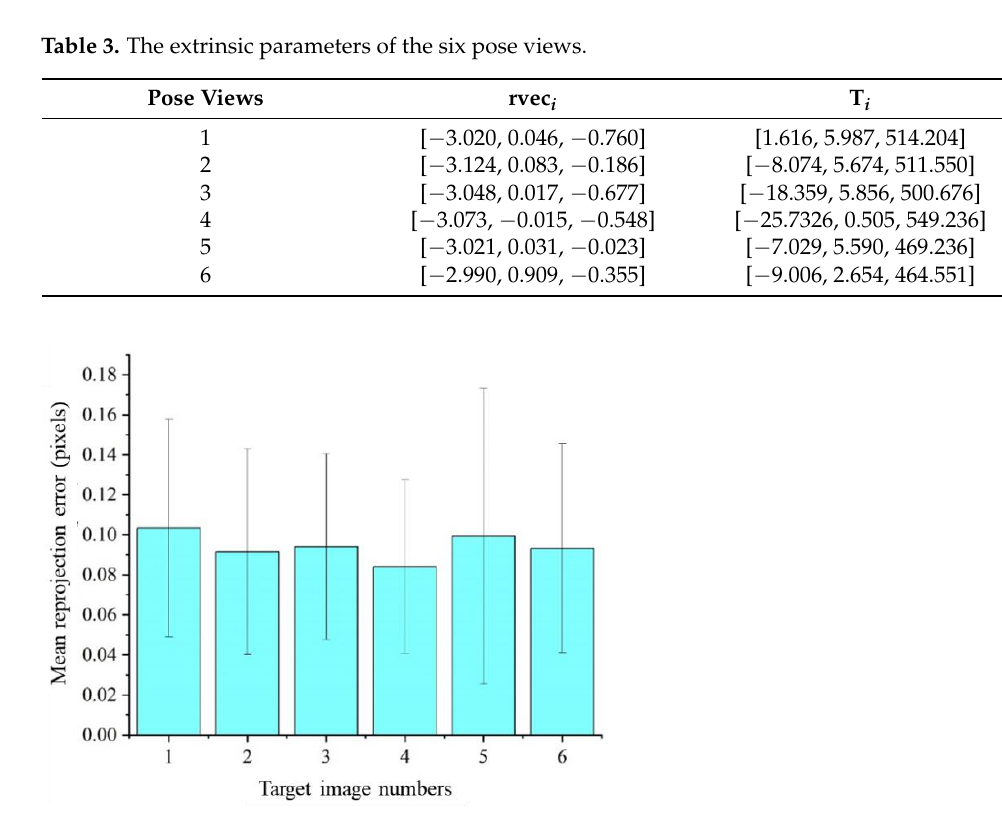
Figure 13. The mean reprojection errors.